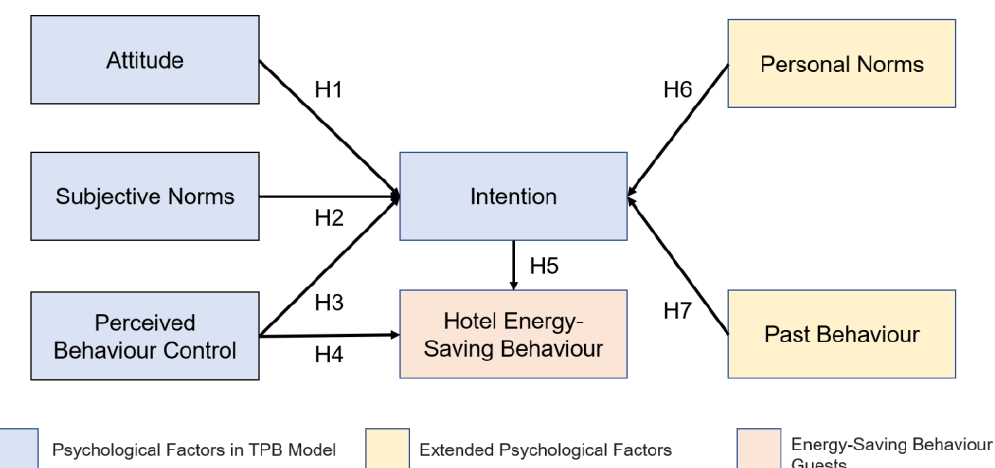
Figure 1. The employed theoretical model and hypotheses in extended model I.